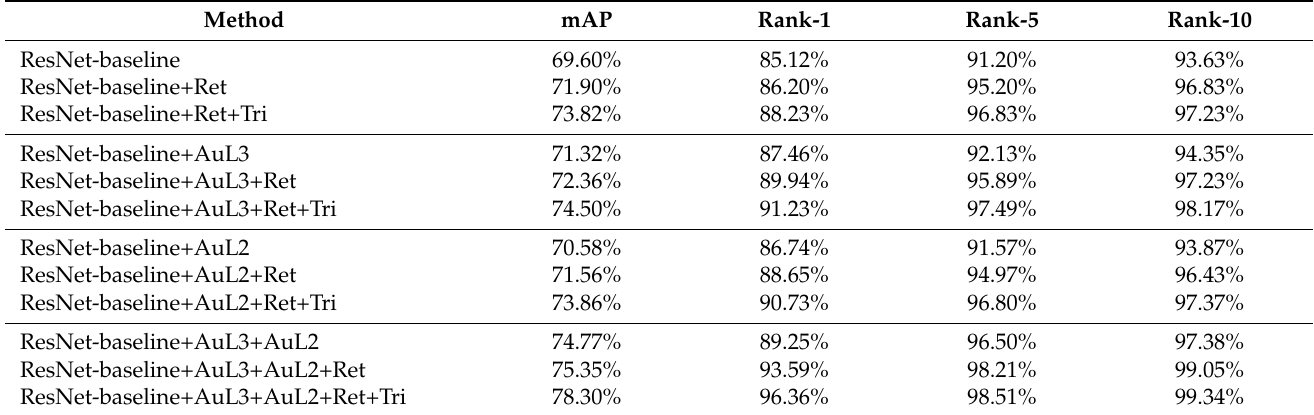
Table 1. Ablation study results on the VeRi-776